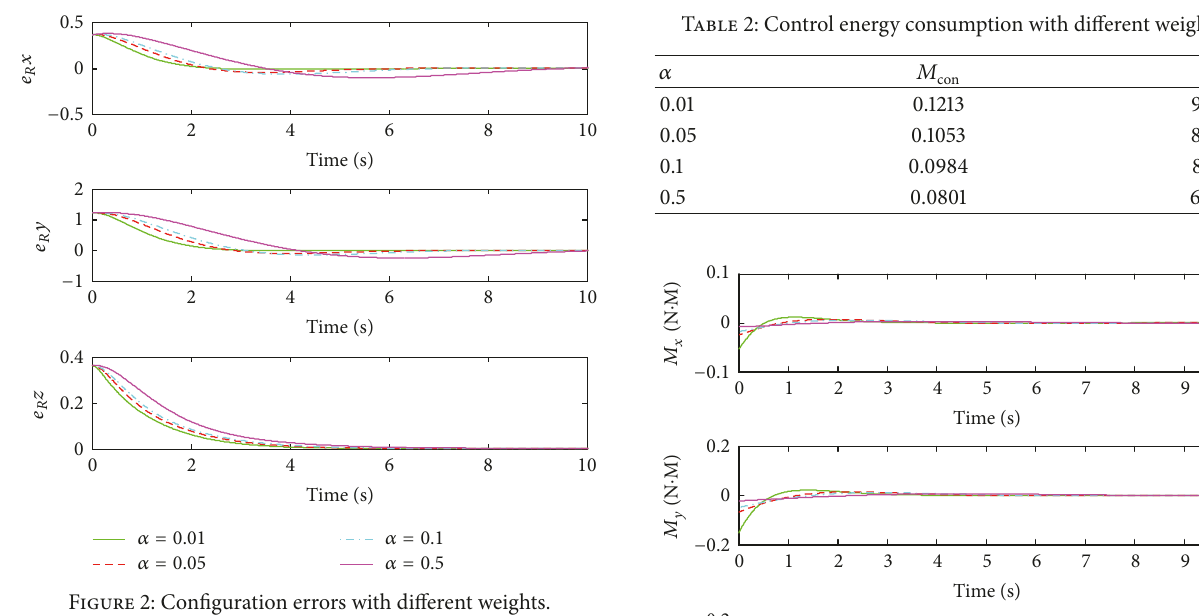
Figure 2: Configuration errors with different weights.